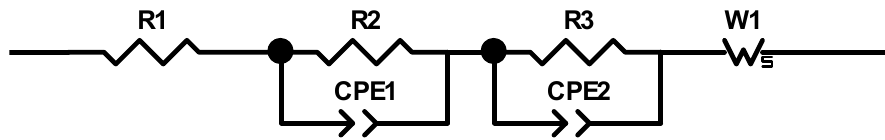
Figure 9. Equivalent circuit for the coin cells with ohmic resistances (R1, R2, R3), constant phase elements (CPE1, CPE2), and finite length Warburg element (W1).